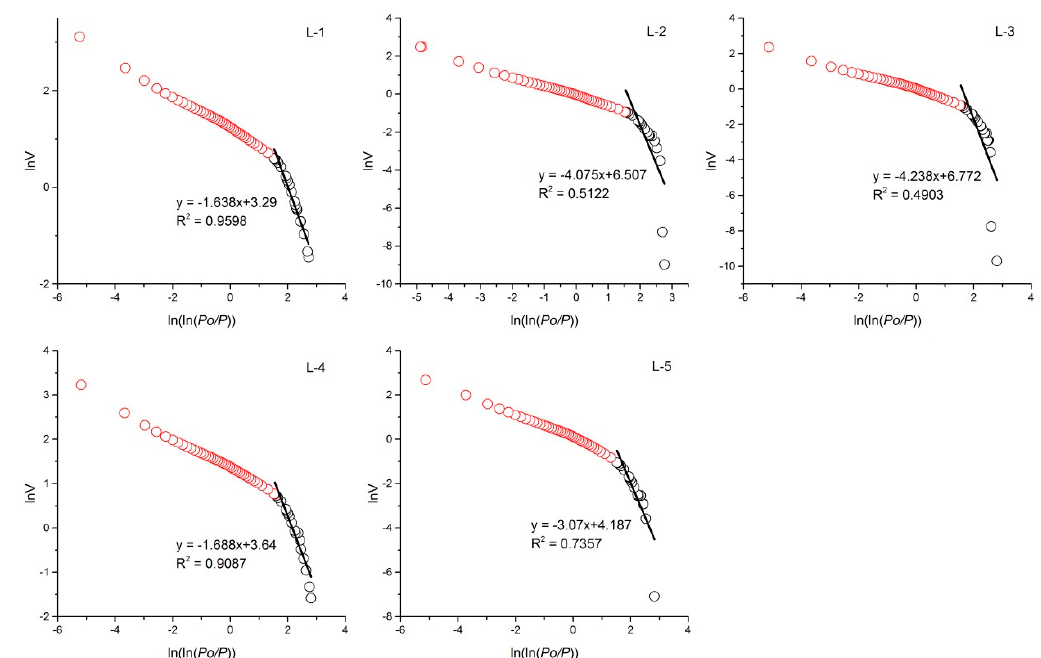
Figure 7. Fractal dimension calculation results with ln V versus ln(ln( P o / P )) from N 2 adsorption isotherms. All the data points on the adsorption curve are shown in this figure. The fractal diameter calculated from the slope of the fitting line, which was made from the black data points of each diagram, is invalid and meaningless. The red data points were used to make the fitting line. The relevant results were shown in the next figure. R 2 is the correlation coefficient.